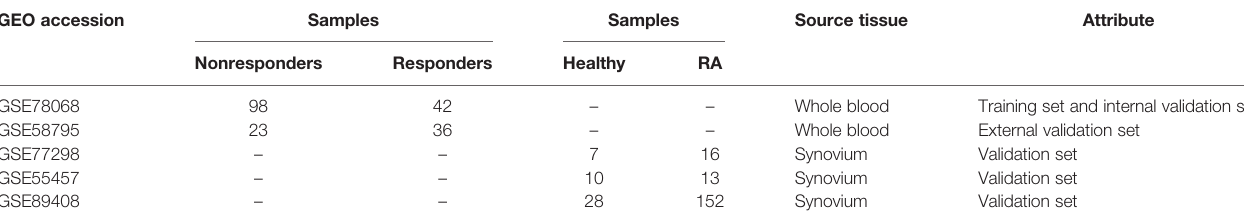
TABLE 2 | Information for selected